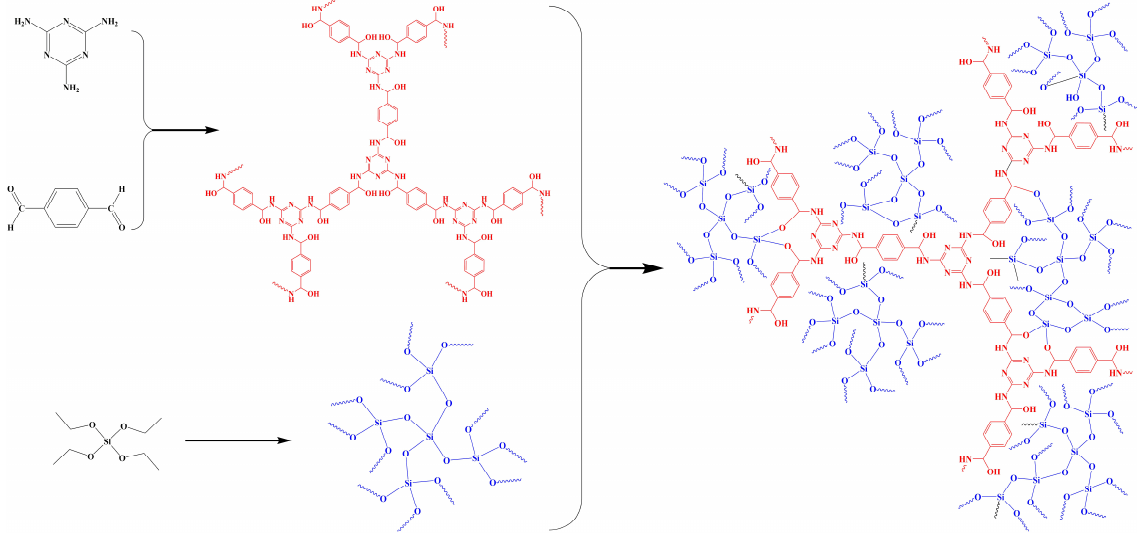
Figure 1. Preparation mechanism of MT-SiO 2 aerogel.